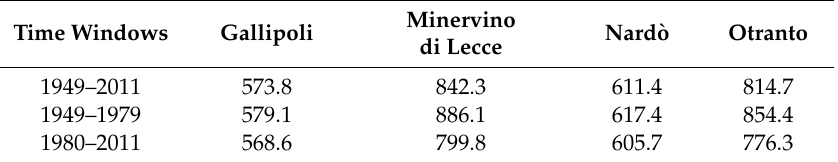
Table 5. Mean values of annual rainfall